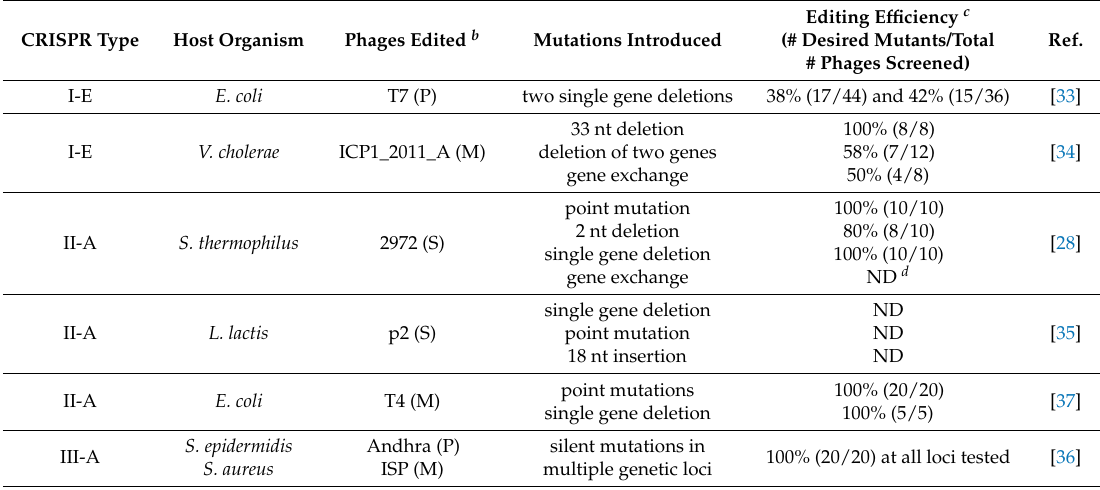
Table 1. Summary of CRISPR–Cas systems used to edit phages and corresponding efficiencies a .